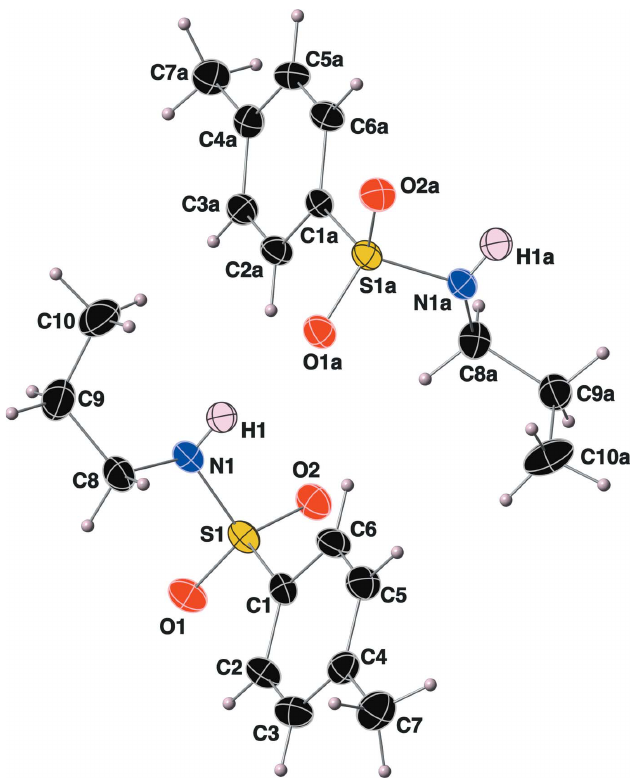
Figure 2 The structures of the two molecules in the asymmetric unit of the title compound, with the atom-labeling scheme. Displacement ellipsoids are shown at the 40% probability level using standard CPK colors.